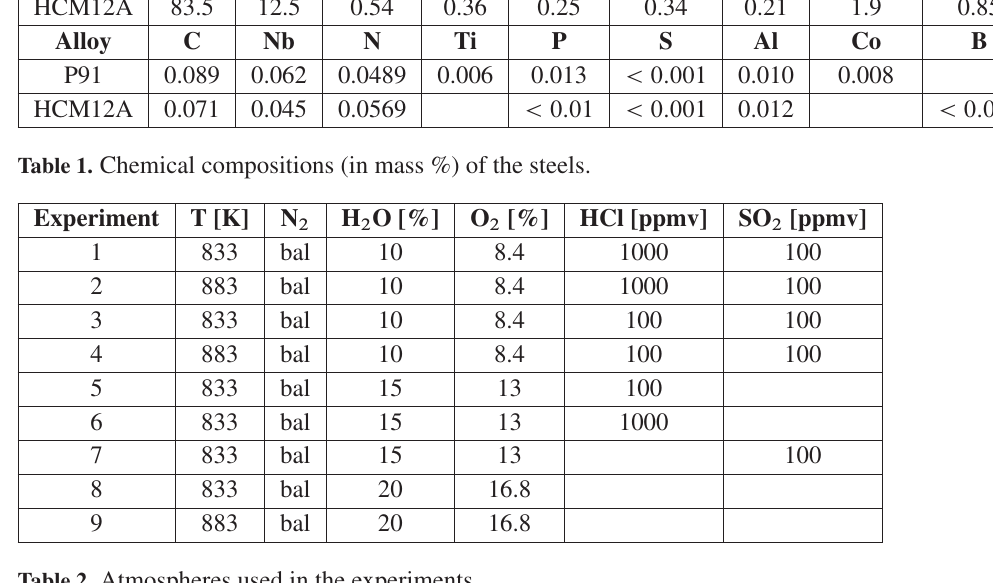
Table 2. Atmospheres used in the experiments.